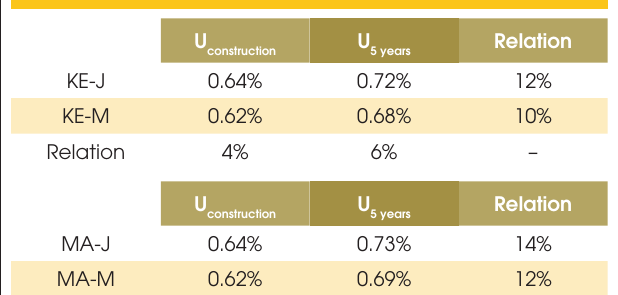
Table 2 – Results relation between different models and time